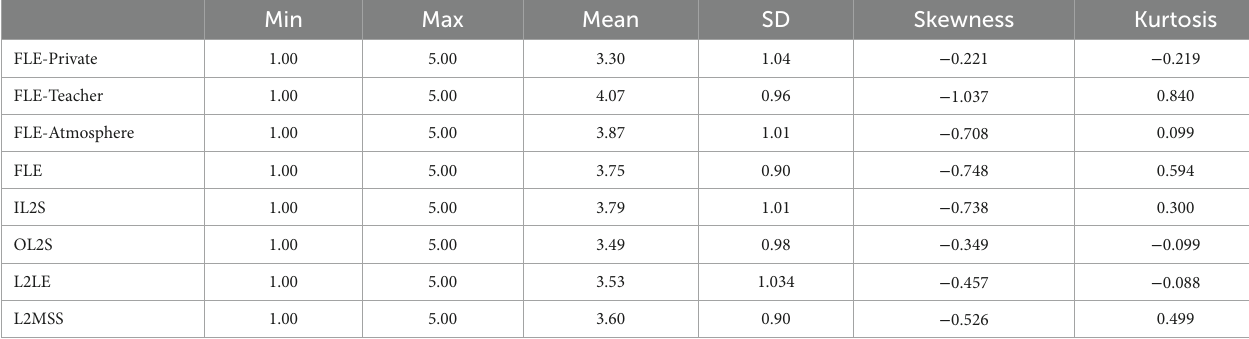
TABLE 1 Descriptive statistics of FLE and